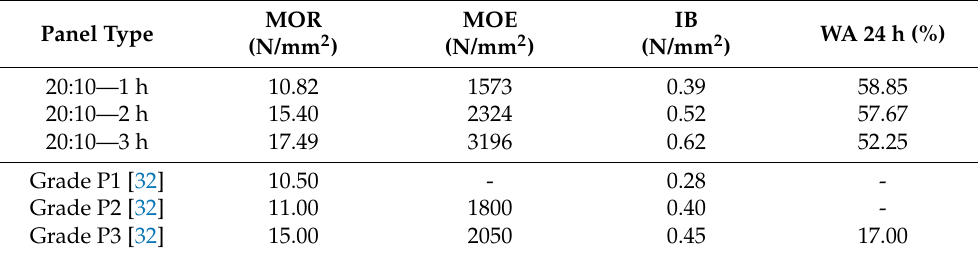
Table 4. Comparison of the properties of the experimental panels with 10% starch and the European standards [32].